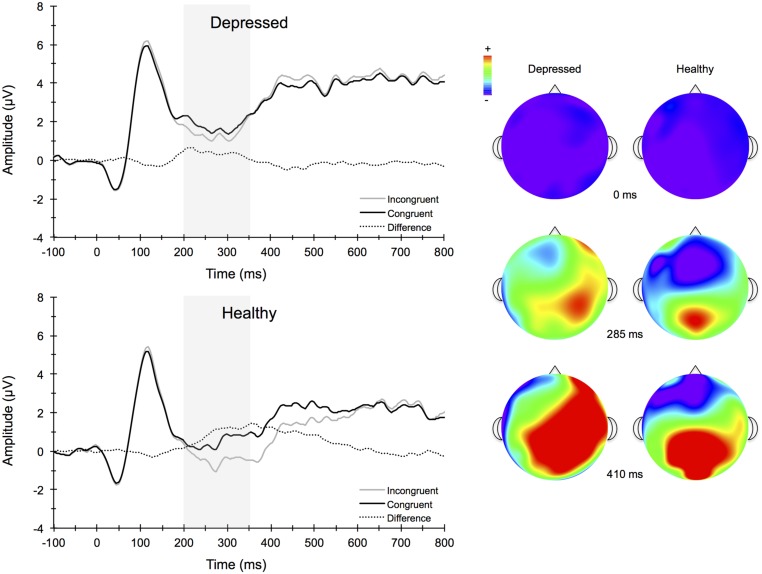
Stimulus-locked grand average ERP waveforms for congruent (top left) and incongruent (bottom left) flanker conditions averaged across frontocentral midline electrode sites Fz, FCz, and Cz. Topographic scalp maps (right) collapsed across congruency for depressed and healthy participants.